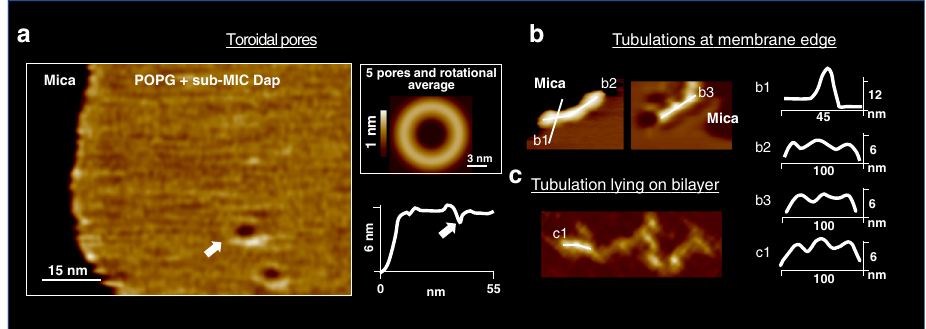
Fig. 5 Sub-MIC Dap on POPG at 37 °C. Hours. Final stages. a Toroidal pores of similar topography than those formed from the fusion of a hump and a dimple formed. a , left, Two toroidal pores in close to the membrane border, the underlying mica support is indicated (colour scale: 3 nm). a , right, An average, including rotational average, of 5 toroidal pores. Toroidal pores did not diffuse, in sharp contrast to the diffusive dimples. The AFM tip radius was too large for the height pro fi le to assess the depth of the toroidal pores, and thus, if they traversed the membrane (white arrow in height pro fi le). Supplementary Fig. 2 provides further details the AFM topographic pro fi les of the toroidal pores. b Tubulations formed, mostly at the edge of the POPG membranes. The tubulations were nearly rectilinear and displayed regions of larger and thinner cross sections that periodically distributed with a ~34 nm period, which is symptomatic of a two components composition in the tubules, Dap and POPG, at the thinner and larger cross section regions, respectively. Height pro fi les across and along the tubules are shown. c More rarely, tubules were found lying on the POPG bilayer, some sections, the more rectilinear ones (k1), present periodicity in their topography, other, the less rectilinear, do not show topographic